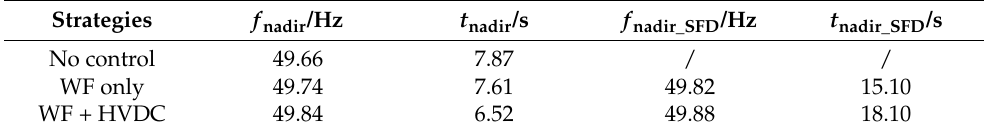
( d ) Figure 18. Simulation results under middle wind power permeability and variable wind speed con- dition. ( a ) Sending-end system frequency, ( b ) active power of WF, and ( c ) active power of HVDC, ( d ) frequency response output of sending-end system.